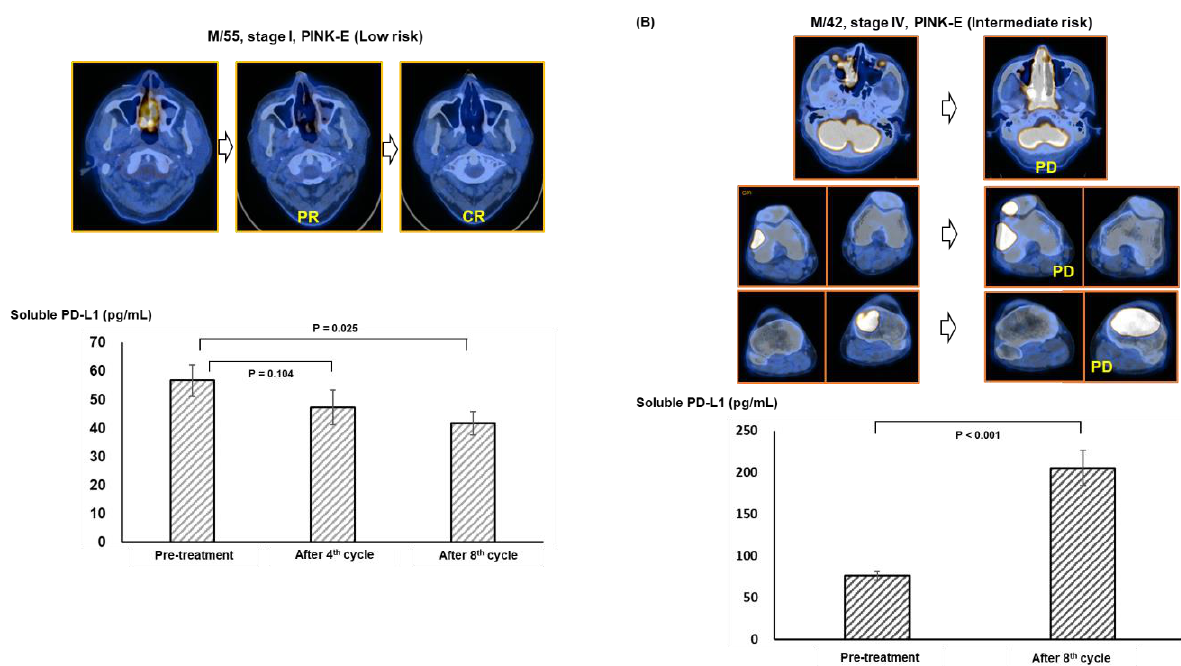
Figure 4. ( A ) A 55-year-old male with stage I and at low risk of PINK-E had a localized 18F -FDG uptake lesion in his nasal cavity on PET/CT, and he achieved complete response after the eighth cycle of pembrolizumab treatment (top). His pre-treatment soluble PD-L1 level was significantly lower than that of the complete response (bottom). ( B ) A 42-year-old male with stage IV and at intermediate risk of PINK-E had multiple 18F -FDG uptake lesions including both the nasal cavity and the knees on PET/CT, and he failed to respond to pembrolizumab treatment (top). At the time of disease progression after the eighth cycle, his soluble PD-L1 significantly increased compared to that of pre-treatment soluble PD-L1 level (bottom).